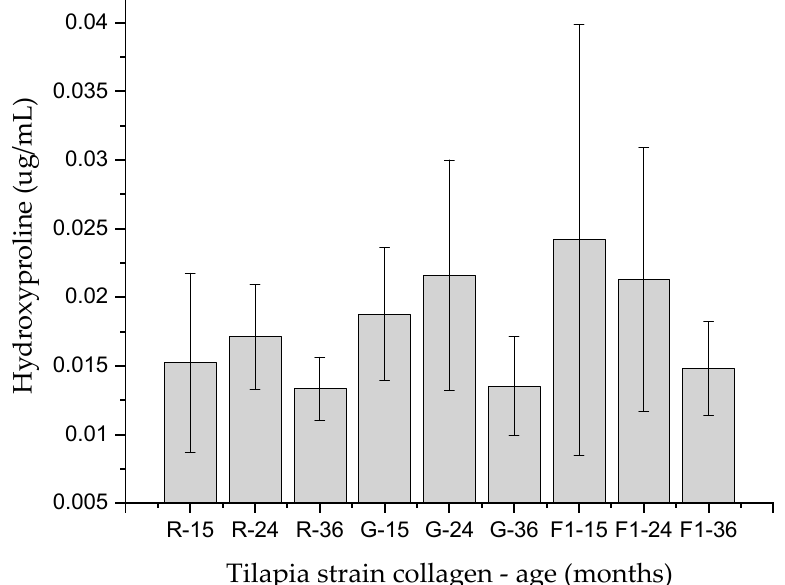
Figure 4. Hydroxyproline ( µ g/mL) in the skin collagen ASC of tilapia strains of 15, 24, and 36 months from adult individuals. No significant differences.